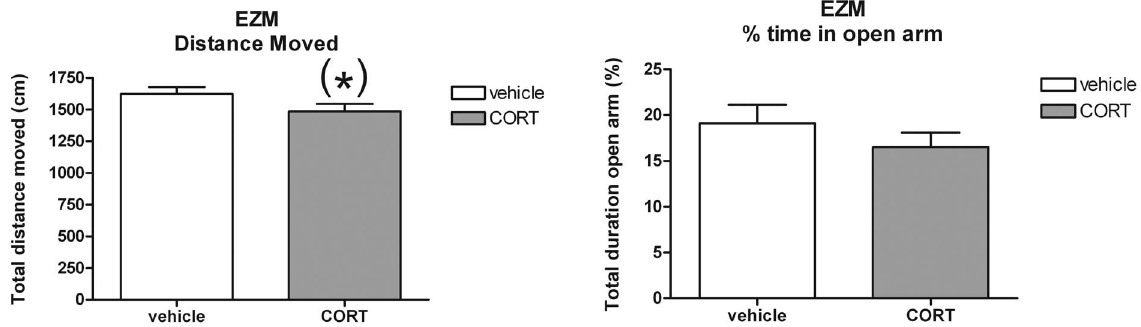
Figure 7. Effect of CORT administration via the drinking water (mean + S.E.M.) upon total distance moved and % time spent in the open arms of the elevated zero maze (EZM). (*) Trend towards difference between CORT and vehicle treatment ( P